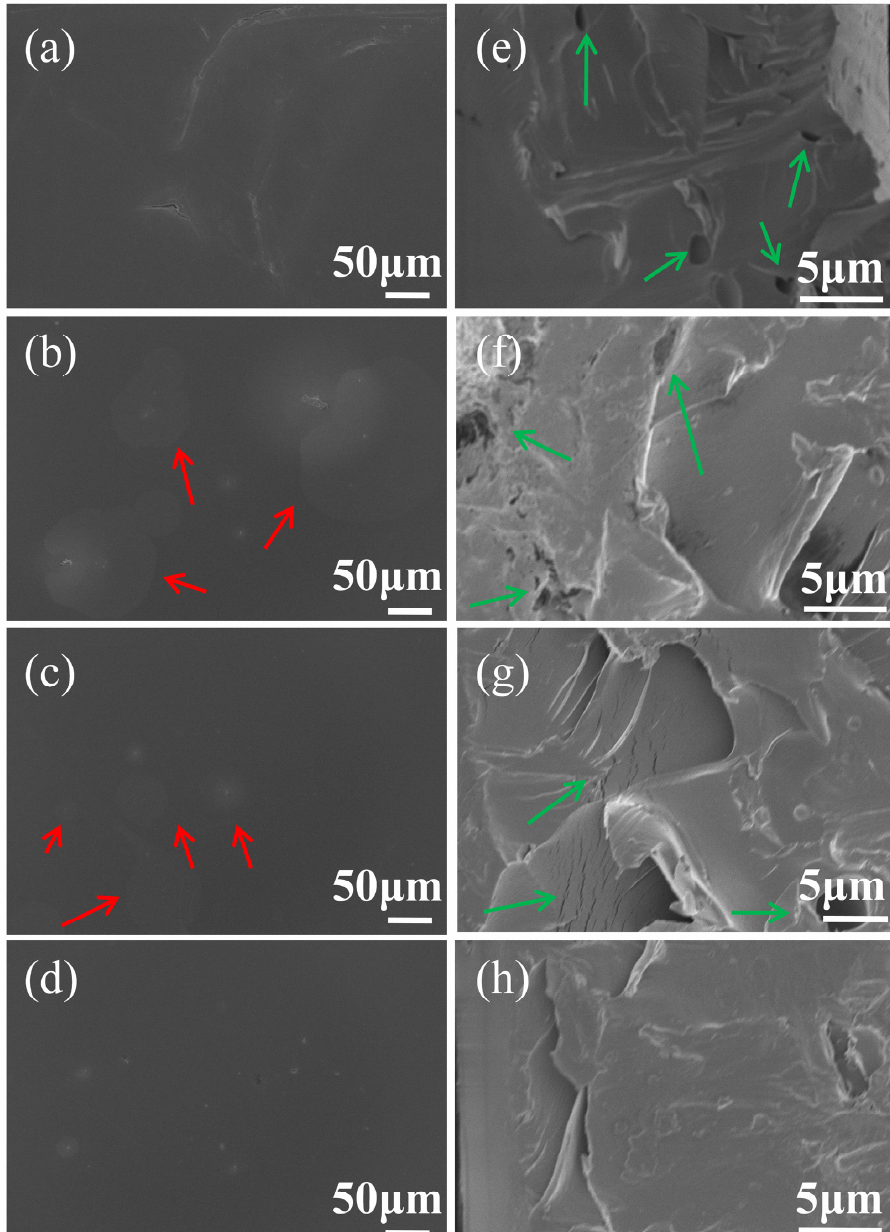
Figure 12. The top-view of coatings ( a ) without the addition of LDHs, ( b ) with addition of 2% MgAl-LDH, ( c ) with addition of 2% ZnAl-LDH and ( d ) addition of 2% CaAl-LDH; The side-view morphology of coatings ( e ) without the addition of LDHs, ( f ) with addition of 2% MgAl-LDH, ( g ) with addition of 2% ZnAl-LDH and ( h ) addition of 2% CaAl-LDH. (Please note that the blisters around the aggregates in the top-view morphologies were indicated by the red arrows and the holes and cracks in the side-view morphologies were indicated by the green arrows)